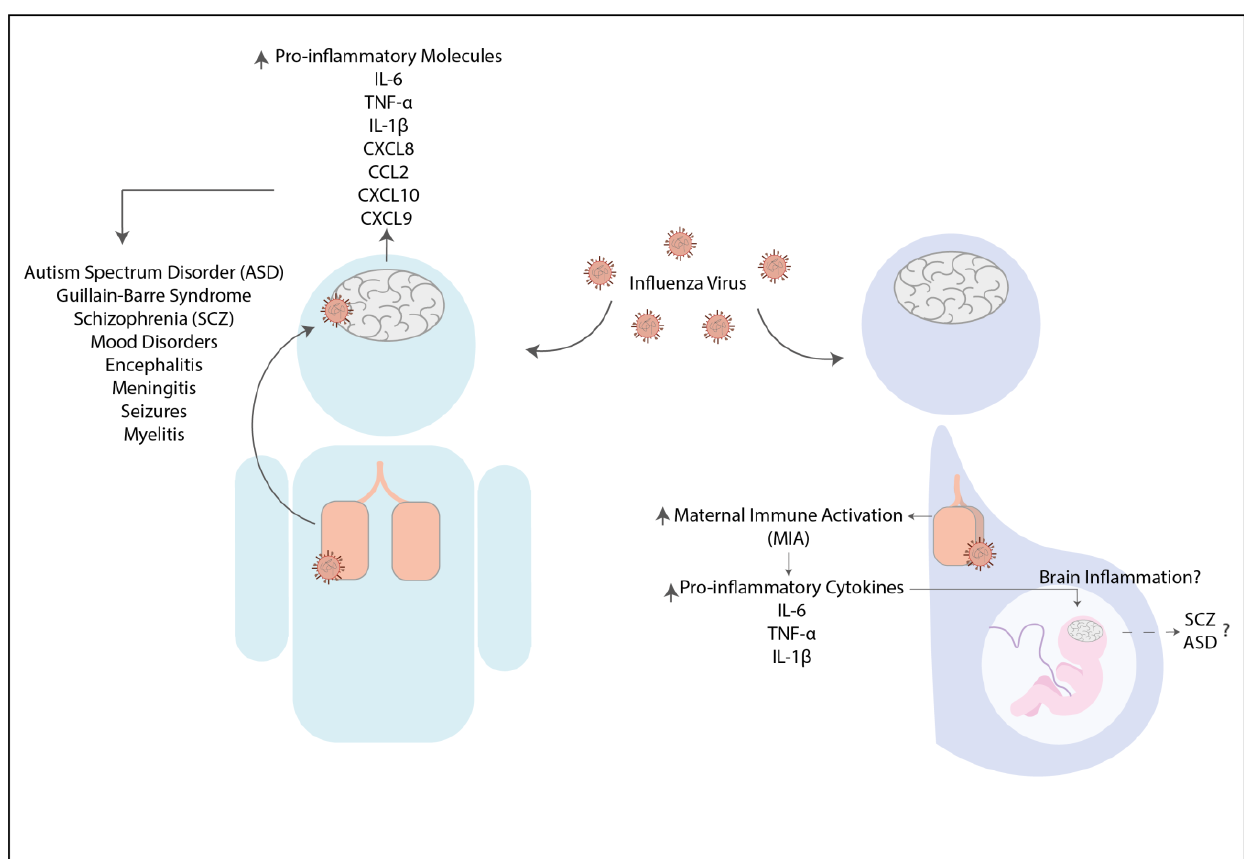
Figure 1. Infections with the influenza virus can cause neurologic consequences directly and indirectly. The respiratory infection with the Influenza virus can lead to neuroinflammation as a consequence of the elevated pro-inflammatory molecules, such as IL-6, TNF-α, IL-1β, CXCL8, CCL2, CXCL10 and CXCL9 [103,107,108]. An increase of these molecules can directly promote the development of neurologic symptoms such as schizophrenia (SCZ), autism spectrum disorder (ASD), myelitis, seizures, meningitis, encephalitis, mood disorders and Guillain-Barré syndrome. On the other hand, the respiratory infection with Influenza virus in pregnant women can increase maternal immune activation (MIA), which increases the secretion of pro-inflammatory cytokines, such as IL-6, TNF-α and IL-1β. An increase expression of these molecules might indirectly promote brain inflammation of the offspring in the uterus, impairing brain development [42,109]. A possible result of brain inflammation is SCZ and ASD [110].